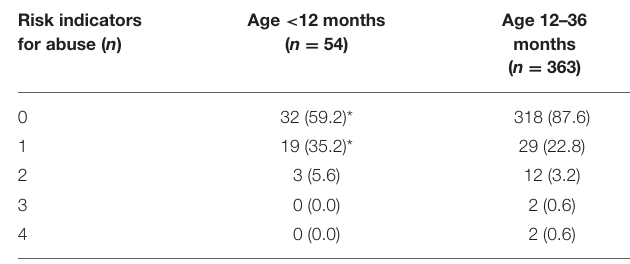
TABLE 1 | Type of skeletal fractures (SFs) diagnosed in the study population according to patient’s age.